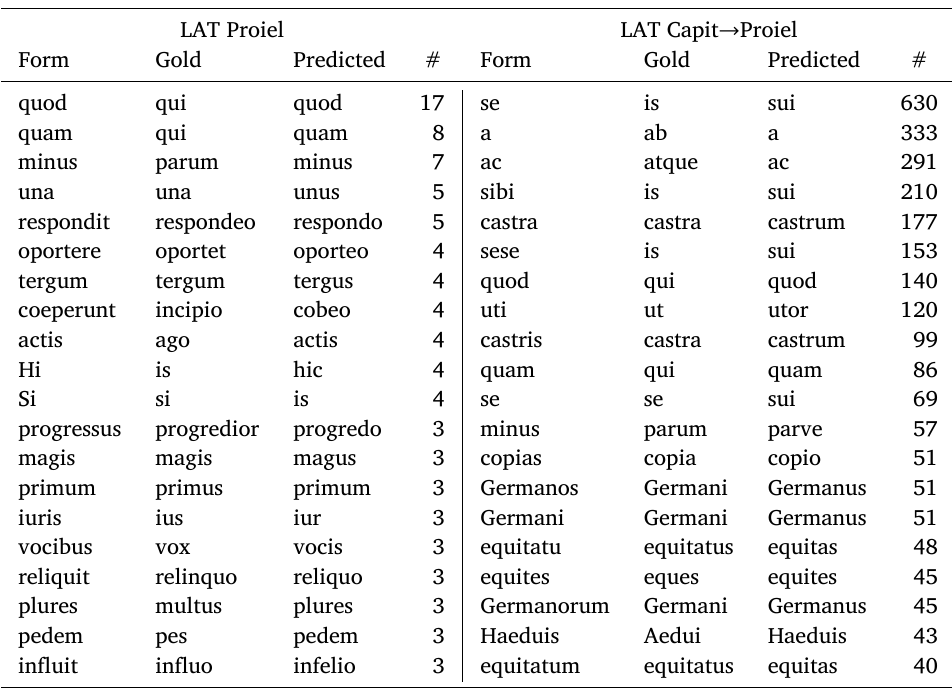
Table 24: Most frequent lemmatization errors for LAT Proiel ID and Capitularies ! Proiel OD LAT